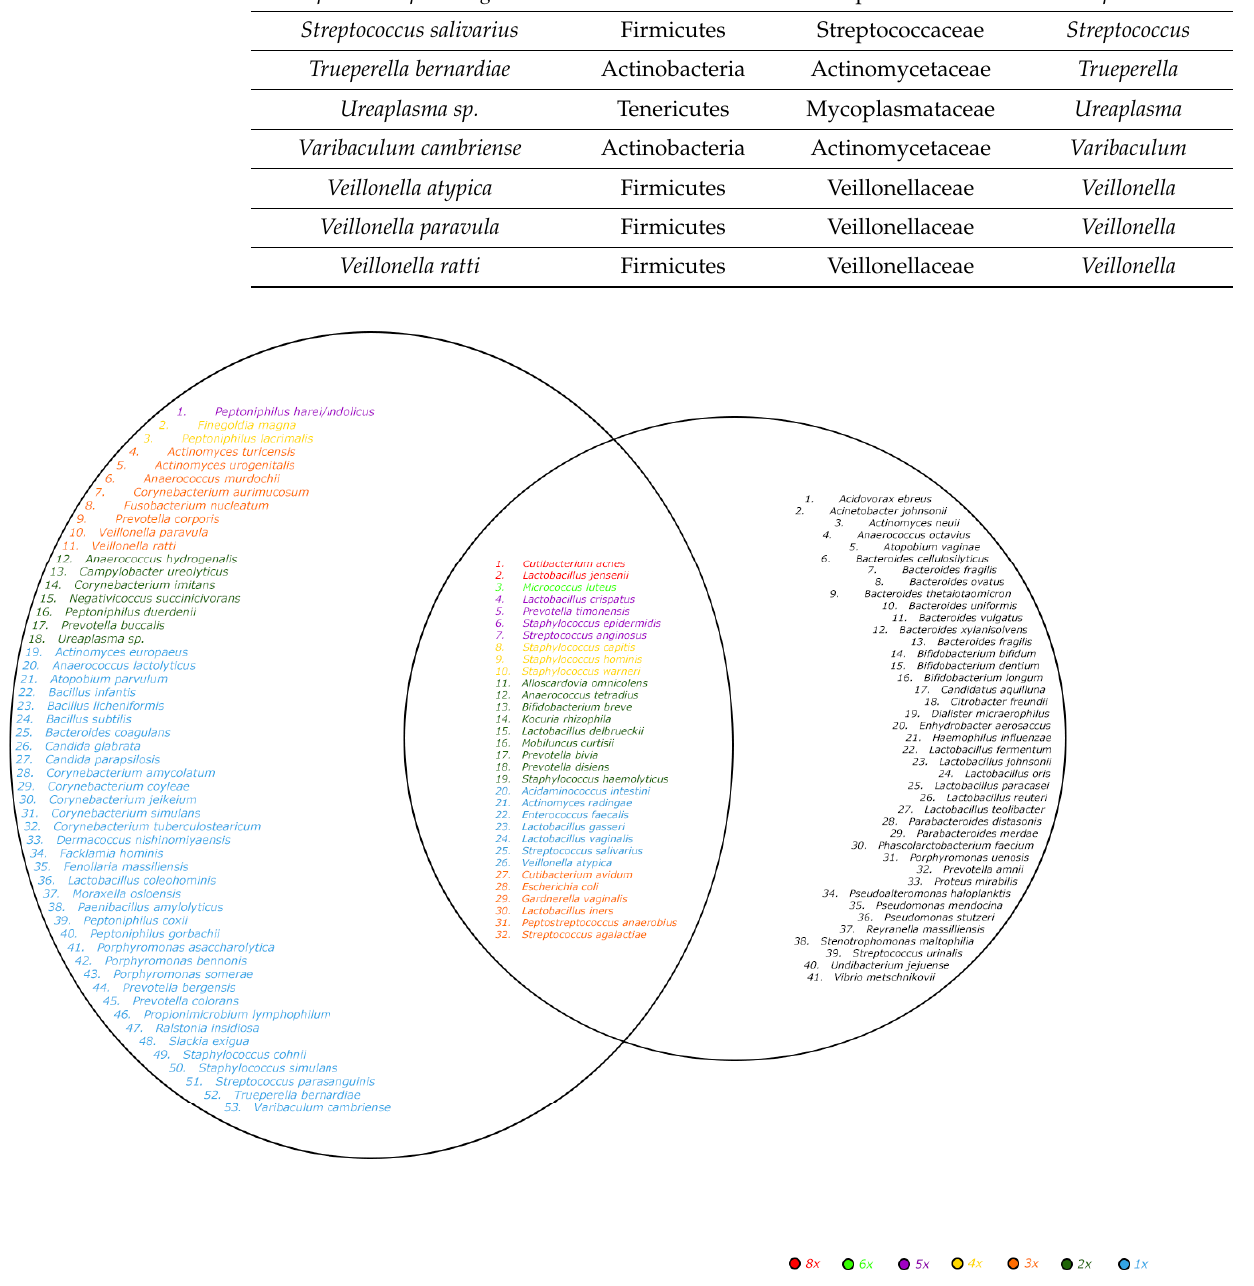
Figure 1. Venn-diagram of described species in the endometrium microbiome. Left circle: species found with our culturomics protocol. Right circle: species described in the literature [7,16]. Inner circle: species found in both our study and the literature [7,16]. The color describes the prevalence over the 10 samples ranging from present in one sample to present in eight samples. Literature overview includes both infertile and subfertile women.